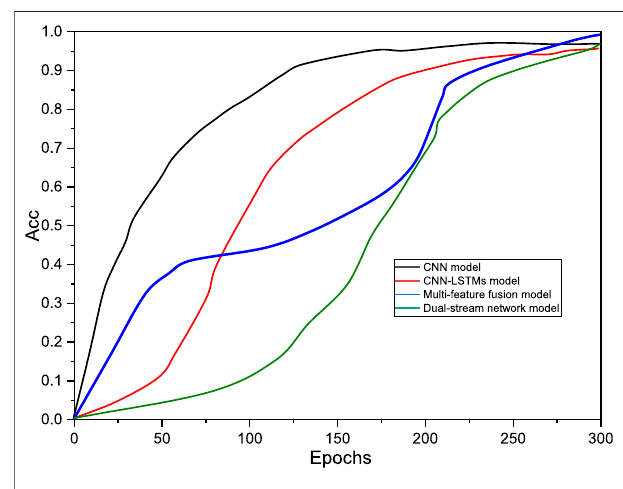
FIGURE 12 | Variation of accuracy for the four